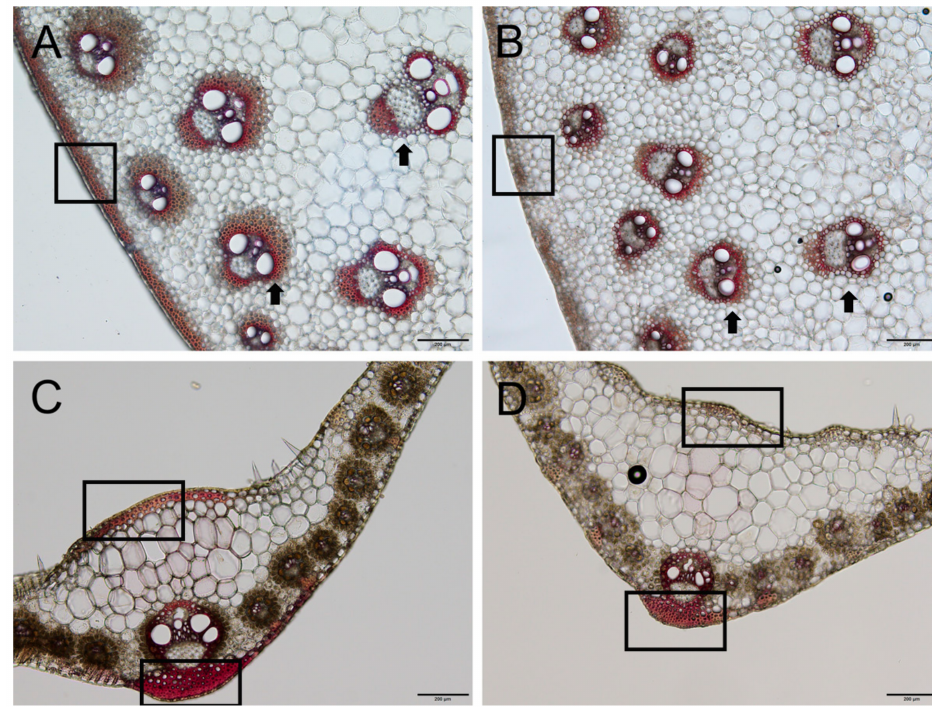
Figure 6. Phloroglucinol staining of lignin in the internodes and leaves. Lignin staining of the seventh internode of the wild-type ( A ) and dnl2 ( B ) at the V15 stage. Lignin staining of the 15th leaf of the wild-type ( C ) and dnl2 ( D ) at the V15 stage. Black arrowheads indicate vascular bundles. The black box indicates the sclerenchyma tissue. Bars = 200 µ m.